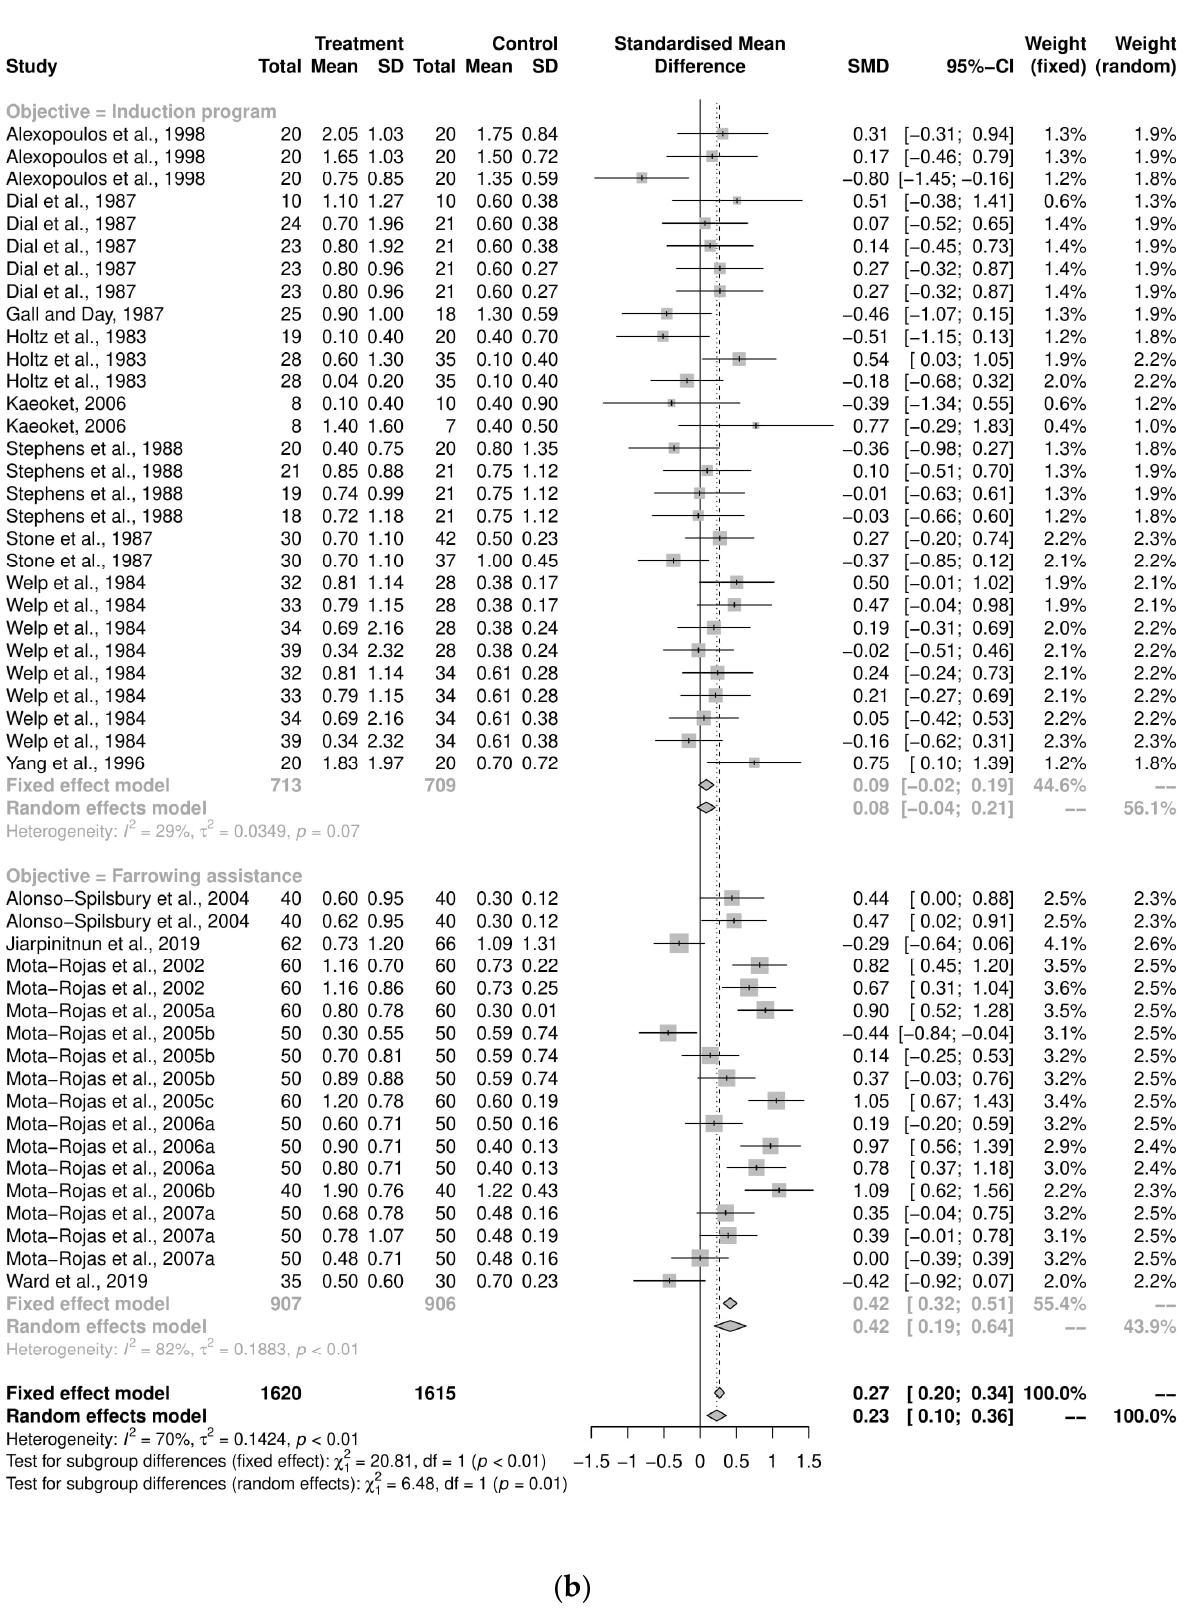
Figure 2. ( a ) Meta-analysis examining mean stillbirths: pooled analysis [29,30,33,35–45,48–49,51–53] ( b ) Sub-group analysis by study objectives (induction program and farrowing assistance)